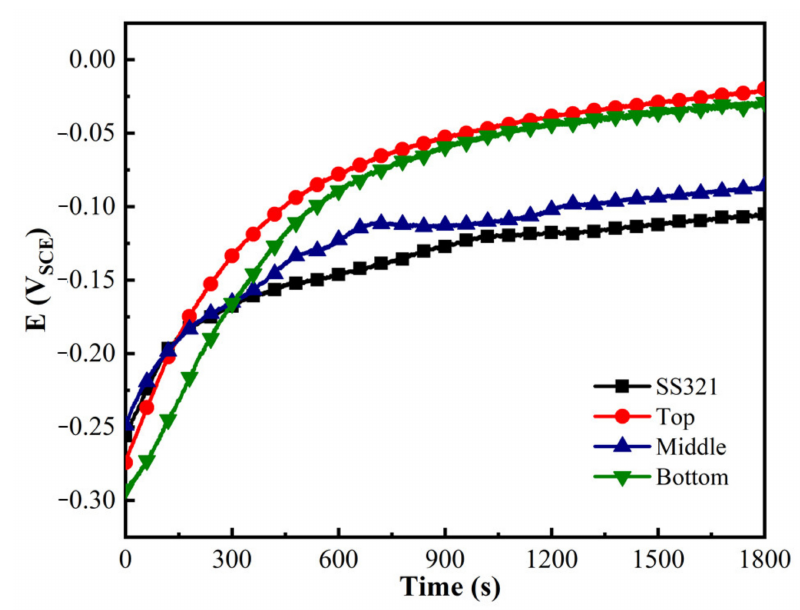
Figure 6. OCP curves of samples with immersion time in 0.5 mol/L H 2 SO 4 solution.